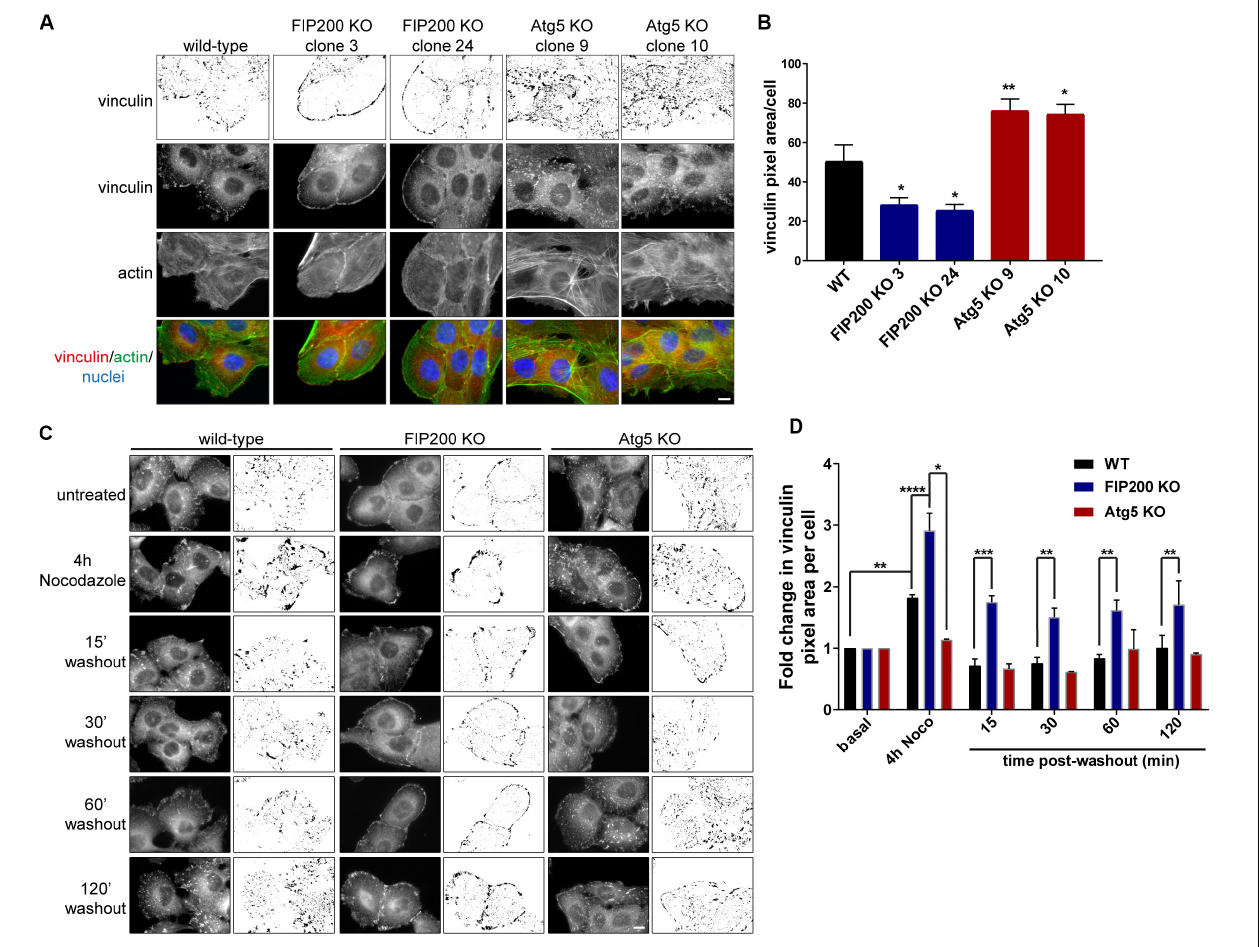
FIGURE 6 | Loss of FIP200 or Atg5 has a differential effect on focal adhesion organization and dynamics. (A) Immunofluorescence microscopy of MCF10A wild-type, two FIP200 KO clones, and two Atg5 KO clones from asynchronous cells cultured in normal growth media was performed against vinculin (green) and actin (red), visualized with phalloidin. Nuclei are labeled with Hoechst (blue). Top panel shows inverted vinculin immunostaining following background subtraction, in order to highlight variation in focal adhesion organization. (B) Quantitation of vinculin immunostaining was performed. Graph represents average vinculin pixel area per cell. Data is comprised of at least 5–10 cells/experiment from random fields of view across 2 independent experiments. (C) Nocodazole assay of MCF10A wild-type, FIP200 KO, and Atg5 KO cells. Cells were either left untreated or treated with Nocodazole for 4 hours in serum-free media prior to washout of Nocodazole and recovery in growth media for indicated time points. Cells were fixed and immunostained for vinculin at each time point. Images are shown as raw monochrome images and inverted images following background subtraction to highlight vinculin focal adhesion staining. (D) Quantitation was performed on vinculin images following background subtraction and represented as the fold change in vinculin pixel area per cell from untreated control. Results represent 3 independent experiments for wild-type and FIP200 KO cells and 2 independent experiments for Atg5 KO cells. * p < 0.05, ** p < 0.01, *** p < 0.001, **** p < 0.0001. Scale bars = 10 µ